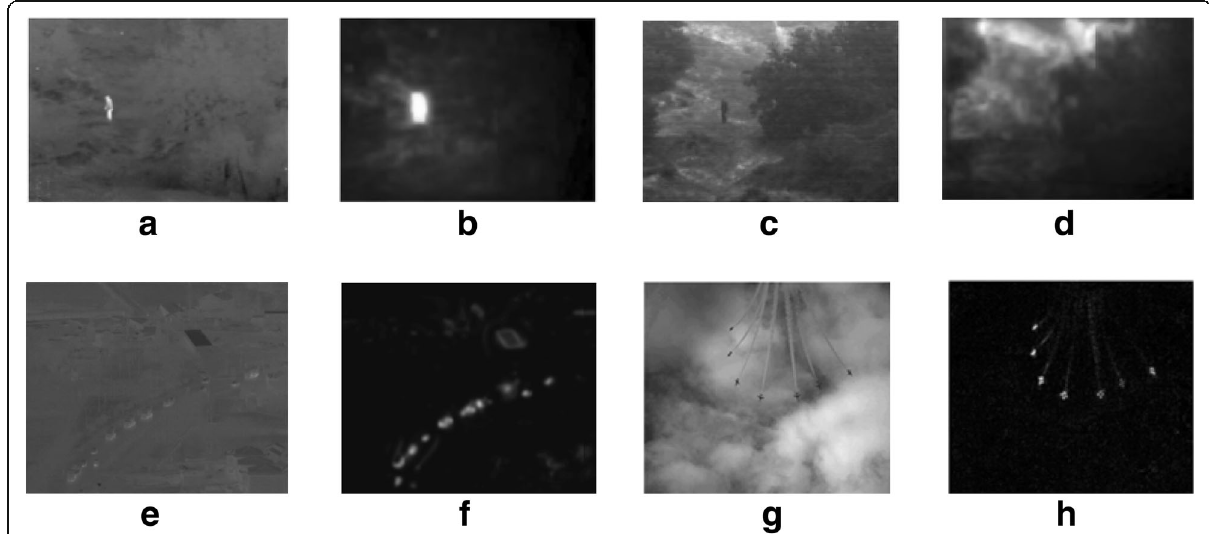
Fig. 1 The visual salient map for infrared image and visible lights. a Infrared image for jungle. b Visual salient map for a . c Visible light image for jungle. d Visual salient map for c . e Infrared image for vehicle. f Visual salient map for e . g Visible light image for plane. h Visual salient map for g